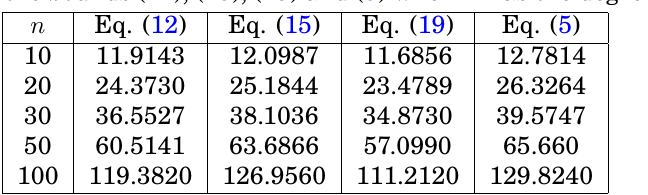
Table 2: Numerical values of the bounds (12), (15), (19) and (5) when T has the degree sequence ( n